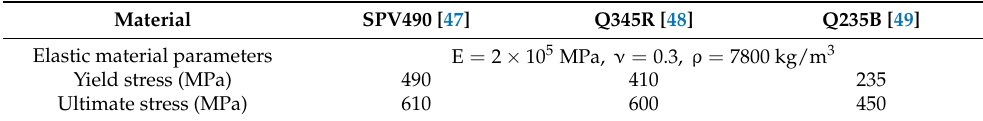
Table 2. The parameters of the materials.